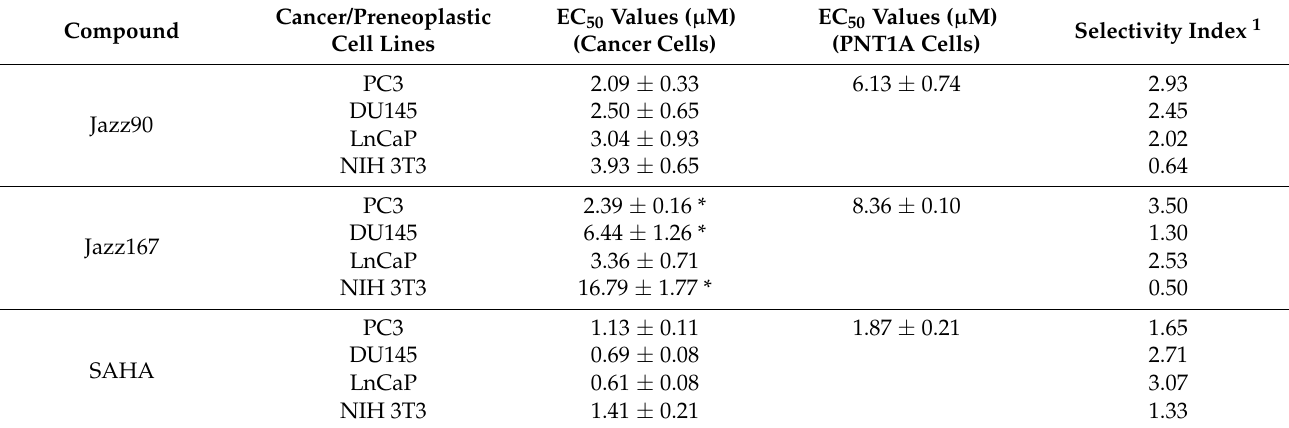
Table 1. Selectivity index of Jazz90 and